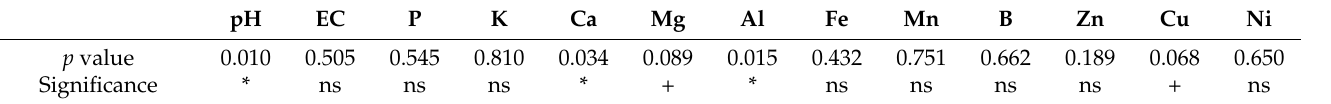
Table 2. Significance of the relationship between years of ginseng cultivation and soil chemical properties.